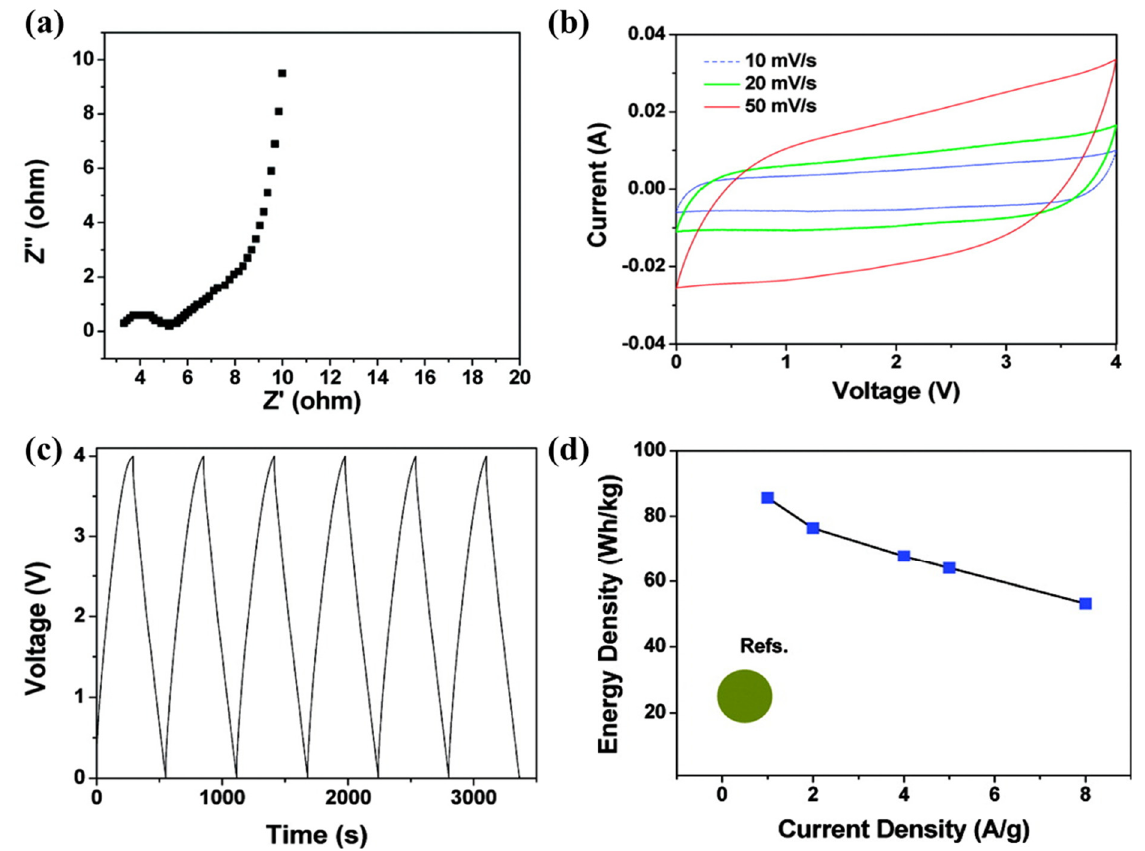
Figure 5. Electrochemical characteristics of graphene electrode using [EMI][BF 4 ]. ( a ) Nyquist plot; ( b ) cyclic voltammograms; ( c ) galvanostatic charge − discharge profile at 1 A g − 1 ; ( d ) Ragone plot compared to previous reports [121–124]. Reprinted 2010 from [101] with permission from the American Chemical Society.